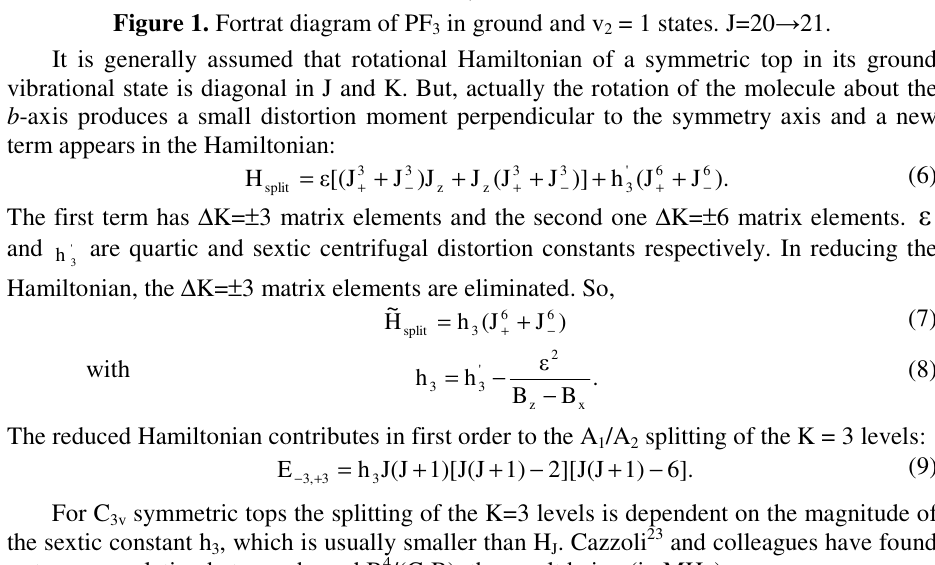
Figure 1. Fortrat diagram of PF